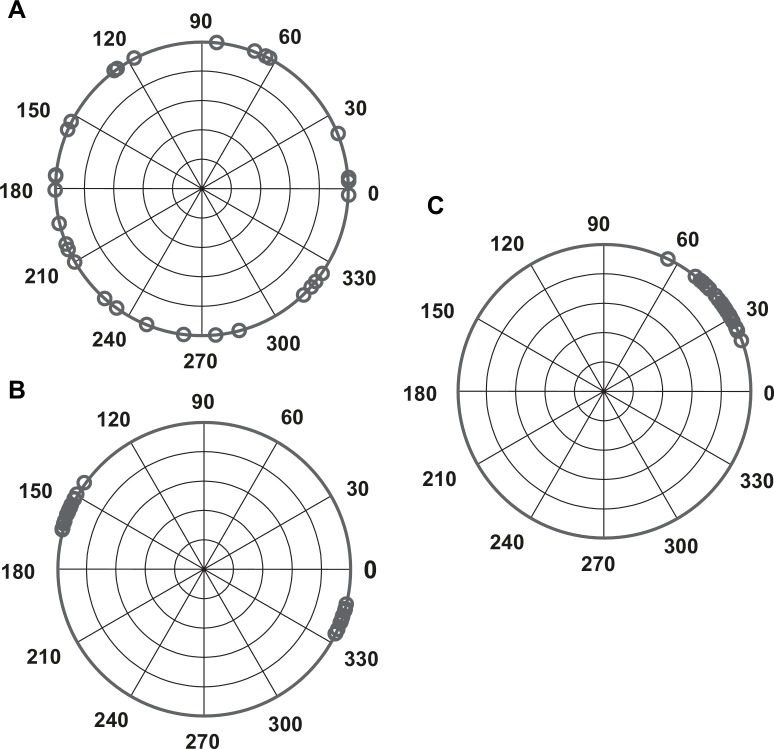
Example distributions of response vectors.A: random distribution, B: bimodal distribution, C: unimodal distribution.